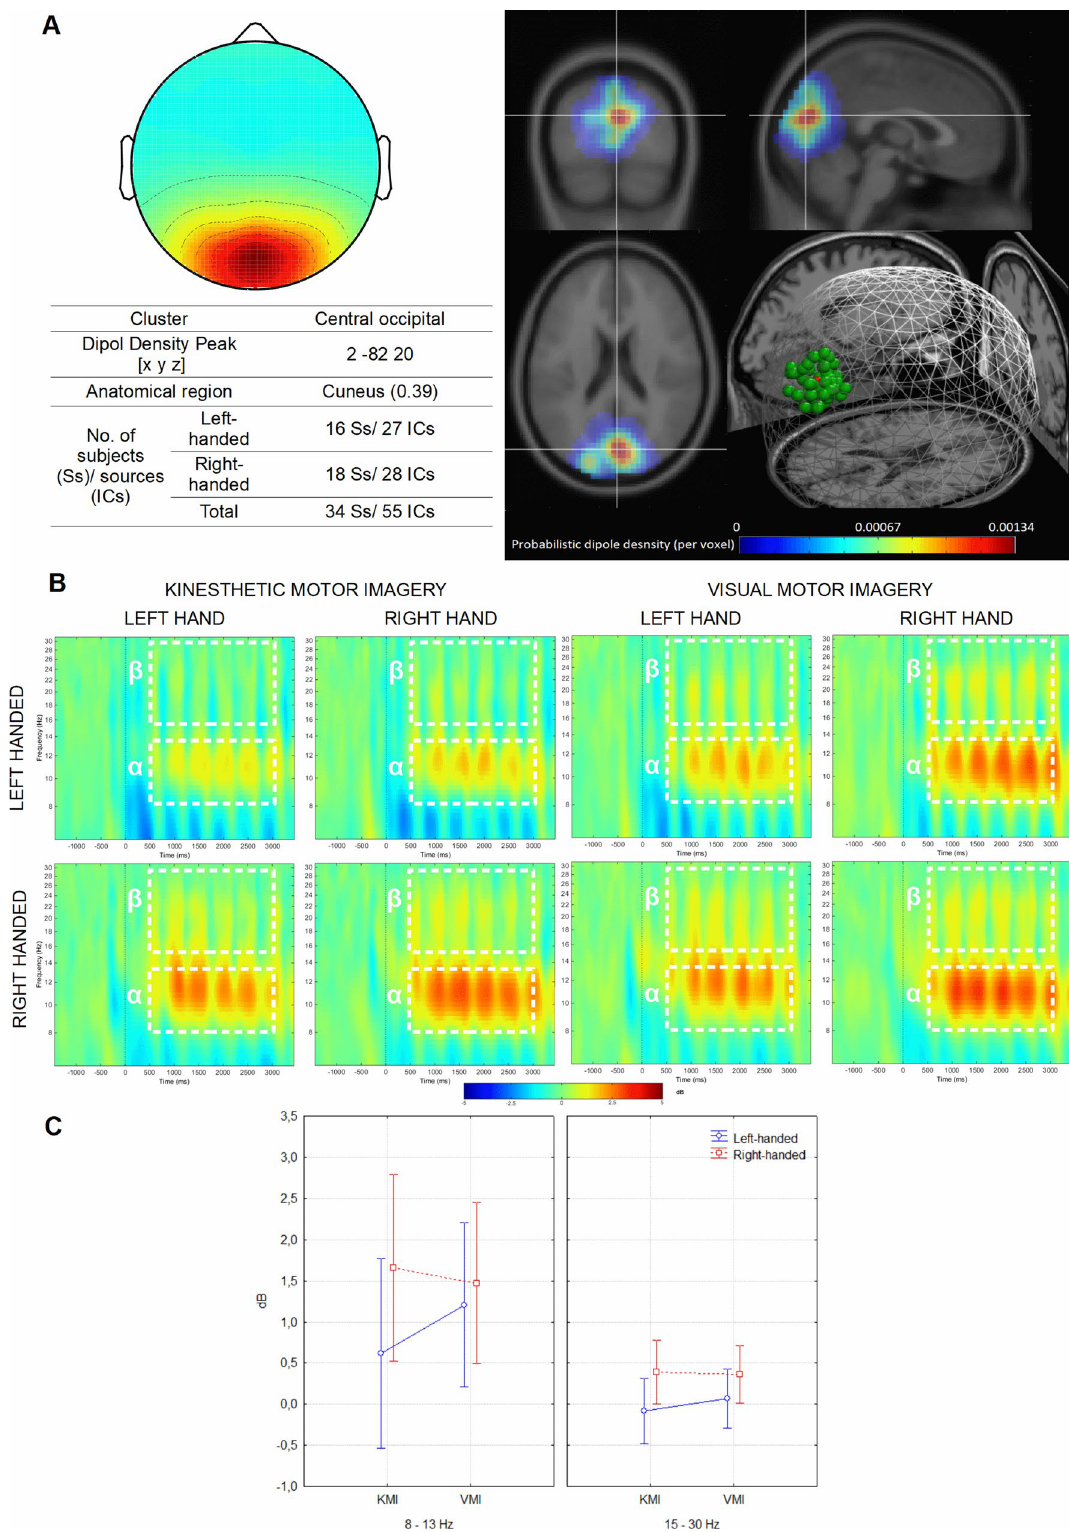
Figure 2. Central occipital cluster. ( A ) Average topography with the estimated anatomical location of the centroid (top left) and visualization of probabilistic dipoles density (top right); ( B ) mean ERSP time × frequency spectrograms from all components for both groups during left- and right hand MI in the KMI and VMI conditions. White dotted lines indicate alpha (α) and beta (β) time–frequency regions averaged for the statistical analysis. ( C ) Differences in alpha and beta band power related to the effects of Frequency × Task × Group. The vertical bars represent standard error. Used software to create the images in this figure: MATLAB